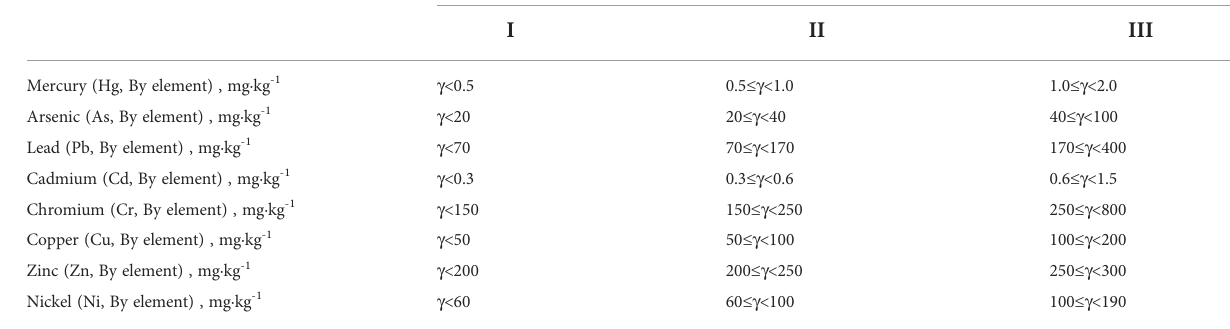
TABLE 3 Requirements for the risk element content control indexes of fl y ash for soil ecological restoration. Project